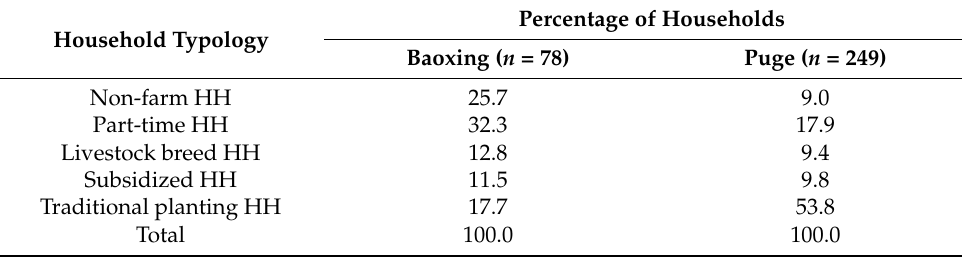
Table 5. Distribution of households by classification criteria from the classification tree method.